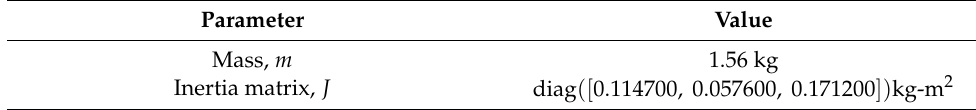
Table 1. Quadcopter properties.